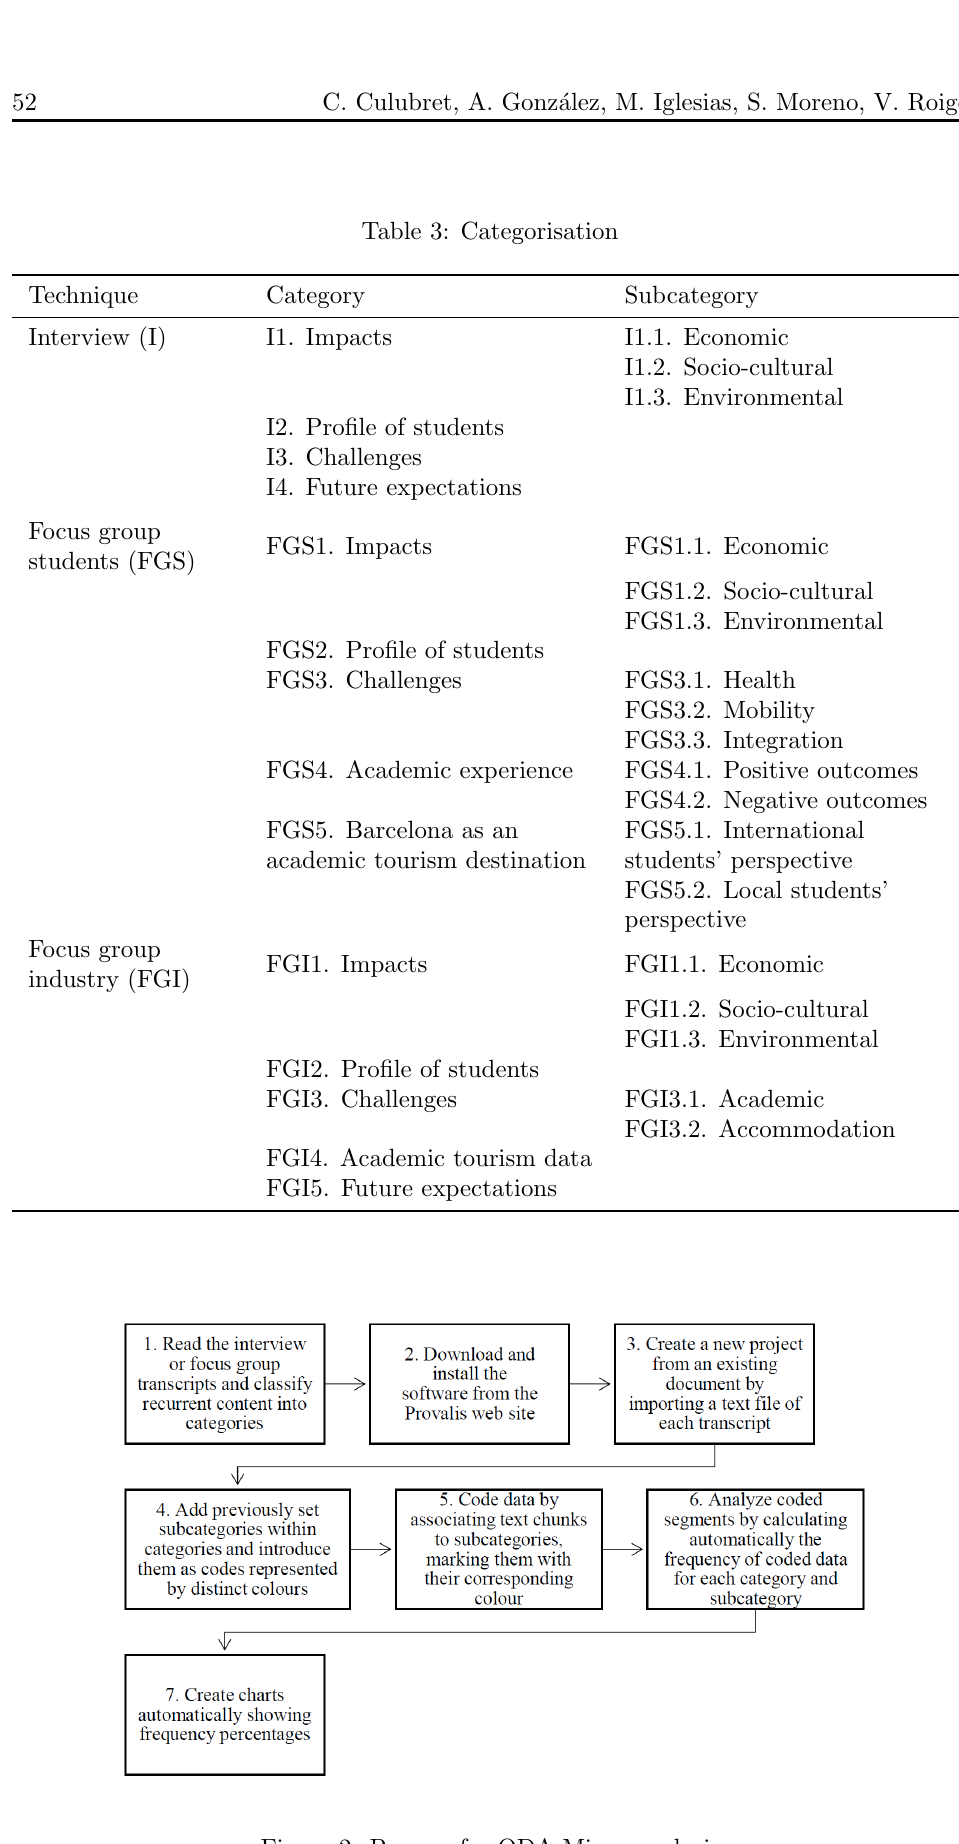
Figure 2: Process for QDA Miner